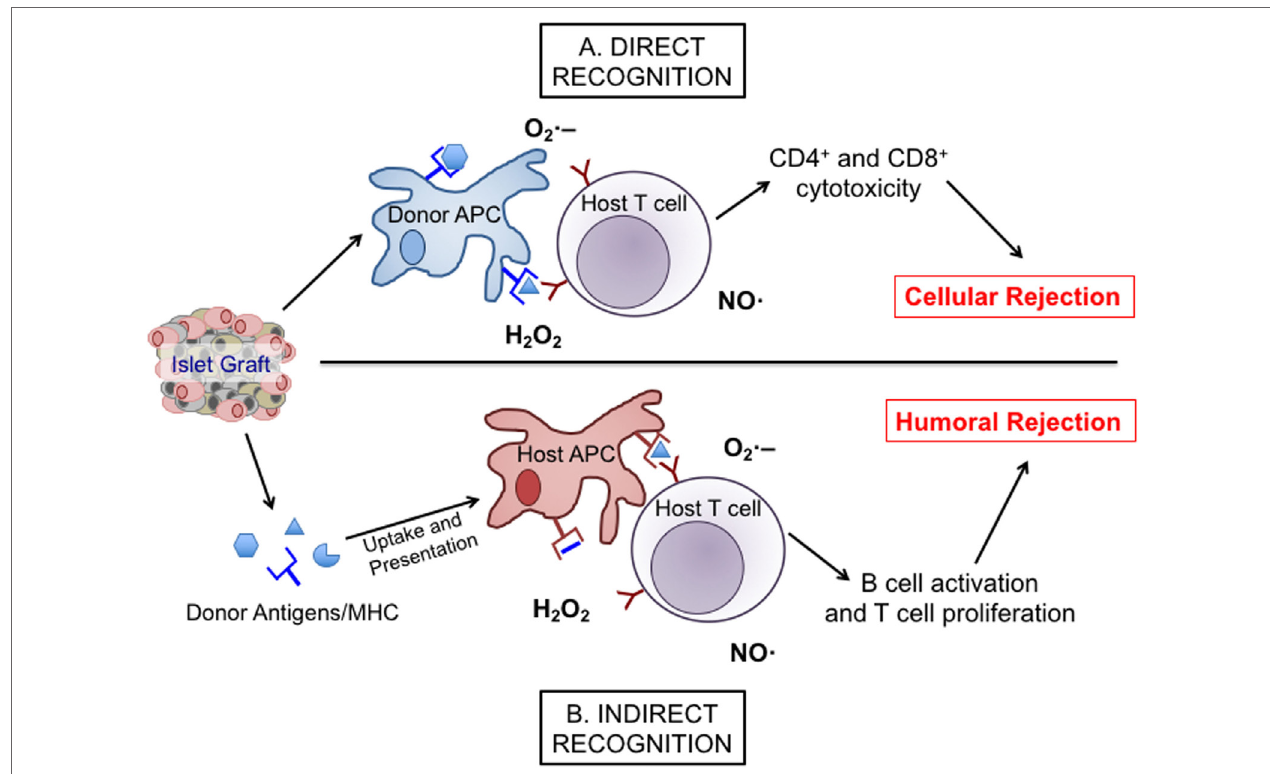
FigURe 1 | The direct and indirect recognition pathways of islet allograft destruction. After transplantation, islet-resident antigen-presenting cells (APCs) from the donor graft can present directly to host T cells with stimulatory signals provided by reactive oxygen species, such as O 2 •− ,  OH, and H 2 O 2 to promote the expansion and activation of alloreactive cytotoxic T cell subsets. This stimulation can then activate inducible nitric oxide synthase (iNOS), NAD(P)H oxidase, and mitochondrial oxidative pathways within the T cell to produce more nitric oxide (NO), hydrogen peroxide, and superoxide, eventually leading to cellular rejection via the direct pathway (A) . Alternatively, islet antigens can be shed into the surrounding environment following transplantation to be engulfed and presented by host APCs and then indirectly presented to host T cells. Through co-stimulation and the release of O 2 •− ,  OH, H 2 O 2 , and NO, those APCs promote a classical antibody response involving the activation and expansion of alloreactive T cells and humoral rejection (B)